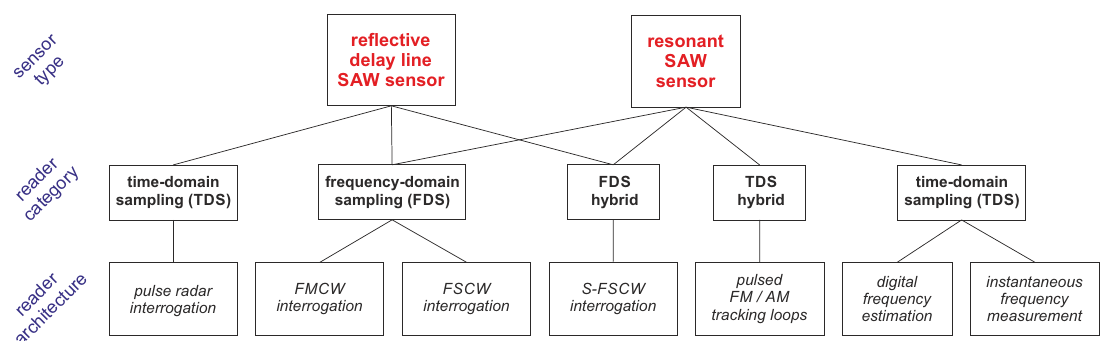
Figure 2. Sensor and current reader architectures with their classification for wireless SAW